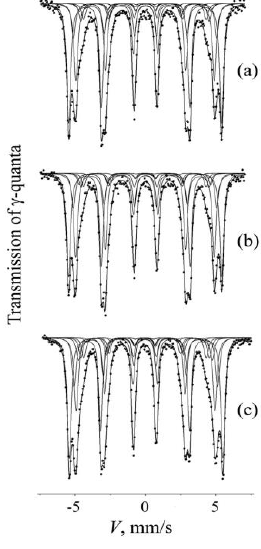
Figure 1. Spectra for the alloy Fe 94 Cr 6 . Treatment (state): ( a ) annealed at 1073 K (as-received); ( b ) as-received and irradiated with (fluence of) F = 2 × 10 22 m −2 at 420 K; ( c ) as-received and HPT (ε = 5.9, n = 3 rev.) at 573 K. Individual subspectra S ( N 1 , N 2 ) corresponding to atomic configurations taken into account are indicated.